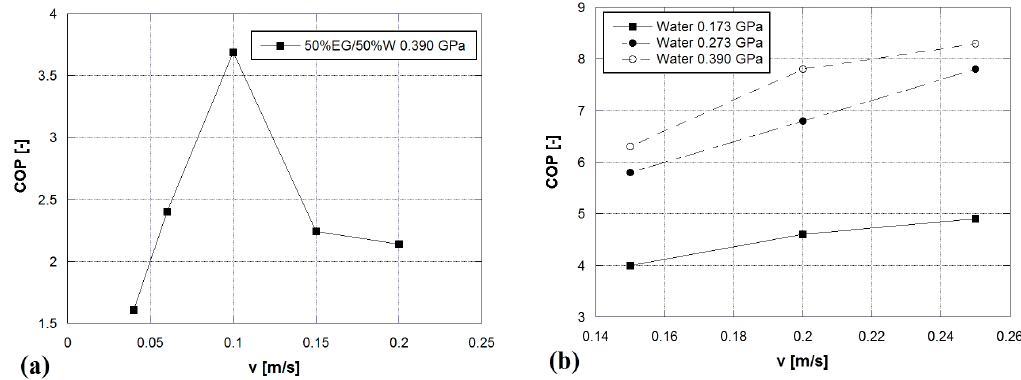
Figure 3. Coefficients of performance detected in: ( a ) cooling mode and ( b ) heat pumping mode, when the system works with base fluids as HTF.